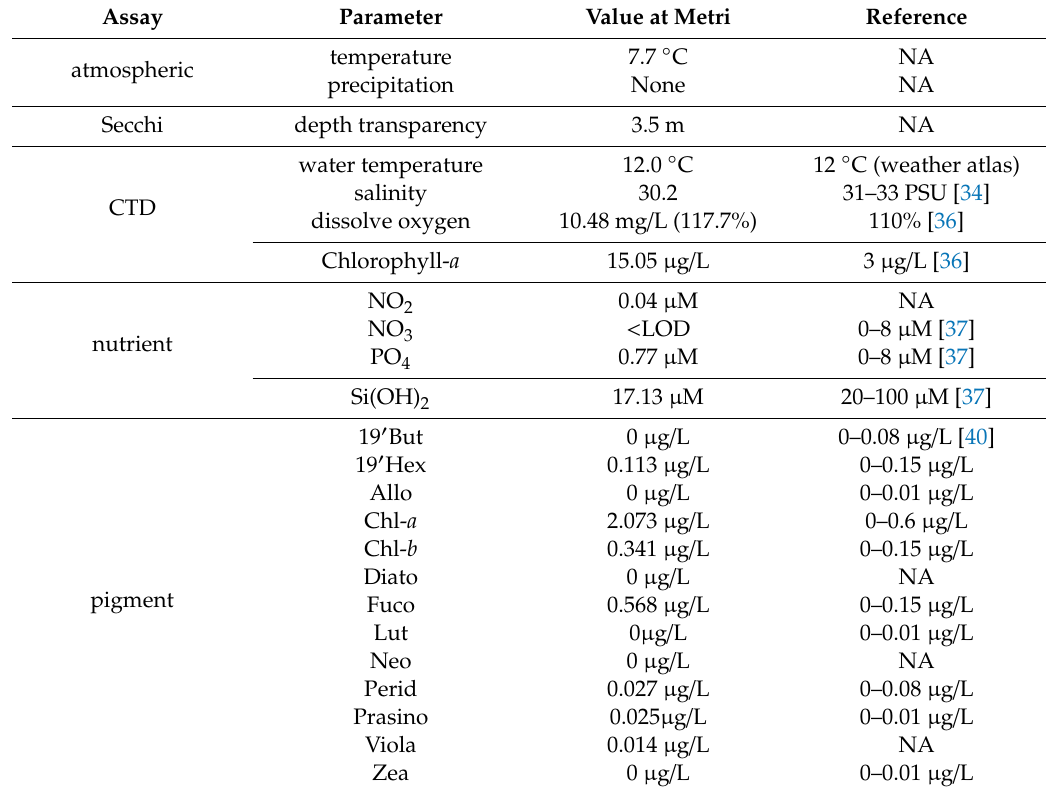
Figure11. Genedetectionofthegenusof Alexandrium and Pseudochattonella by18S-rRNAmetabarcoding Figure 11. Gene detection of the genus of Alexandrium and Pseudochattonella by 18S-rRNA analysis. The water sample was regularly collected from Metri, Chile ( − 41 ◦ 5967 (cid:48) , − 72 ◦ 7056 (cid:48) ) in the fall metabarcoding analysis. The water sample was regularly collected from Metri, Chile (−41°5967′, of 2019. The genes of Alexandrium and Pseudochattonella were detected at some time-points, although −72°7056′) in the fall of 2019. The genes of Alexandrium and Pseudochattonella were detected at some below 1% of relative abundance. time-points, although below 1% of relative abundance. Table 5. Seawater properties at Metri, Chile. On 24 April 2019, the water sample was collected for physical and dissolved nutrient analyses, and on 26 April 2019, for pigment analysis. The values for CTD data at Metri are an average from 0–10 m depth. The atmospheric data were obtained from El Tepual airport in Puerto Montt, the nearest available metrological station to Metri. The reference values for pigment are taken from the plot scales used in Wright et al.